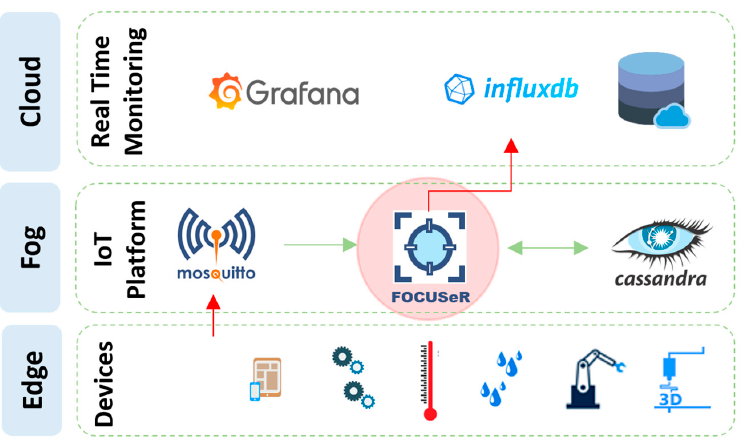
Figure 8. Proposed experimental environment.